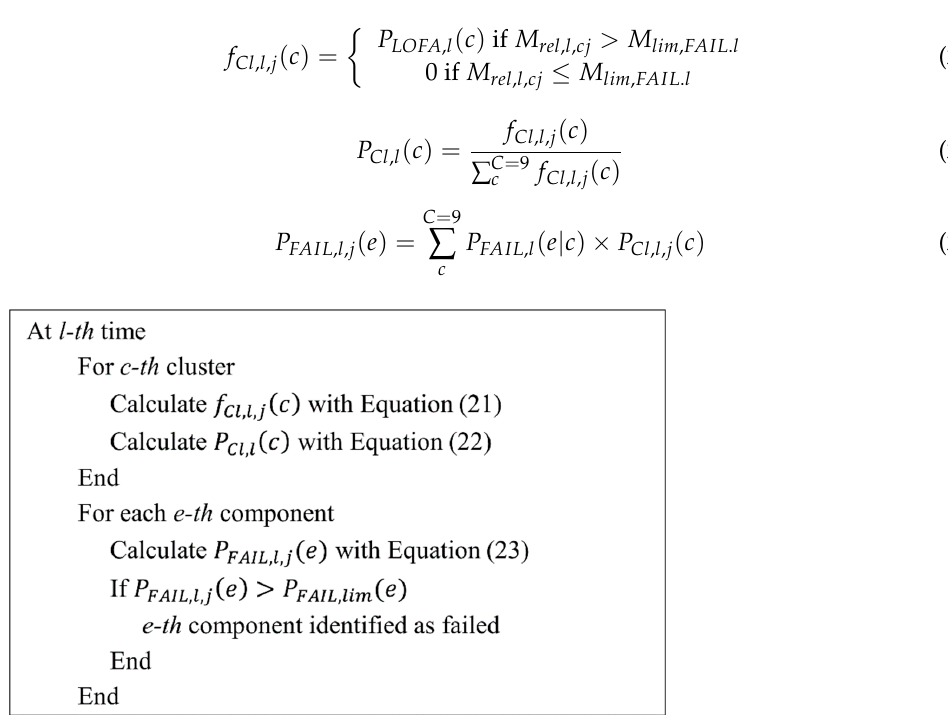
Figure 8. Pseudo code for (cid:1842) (cid:3007)(cid:3002)(cid:3010)(cid:3013),(cid:3039),(cid:3037) ((cid:1857)) analysis.